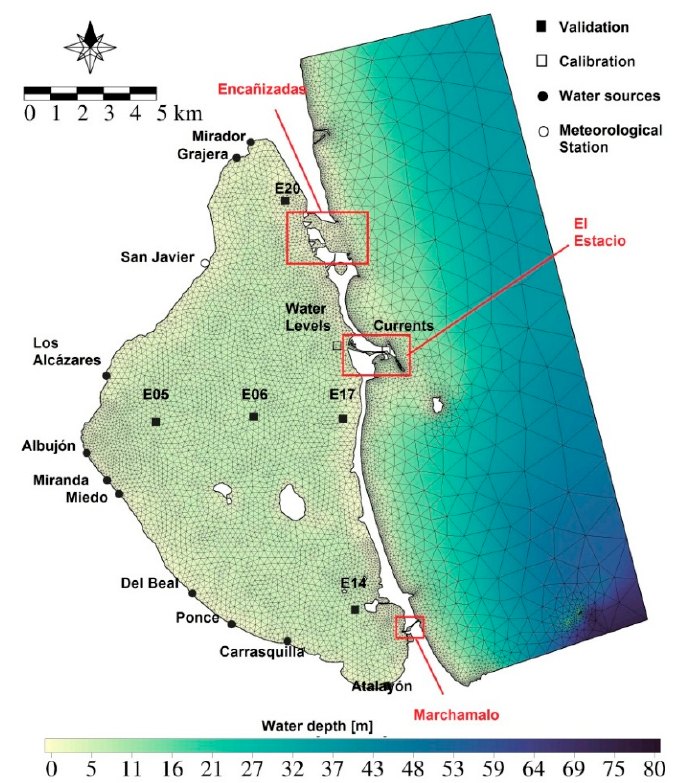
Figure 1. Model domain, bathymetry, channels, water courses, and stations for meteorological data, calibration and validation.